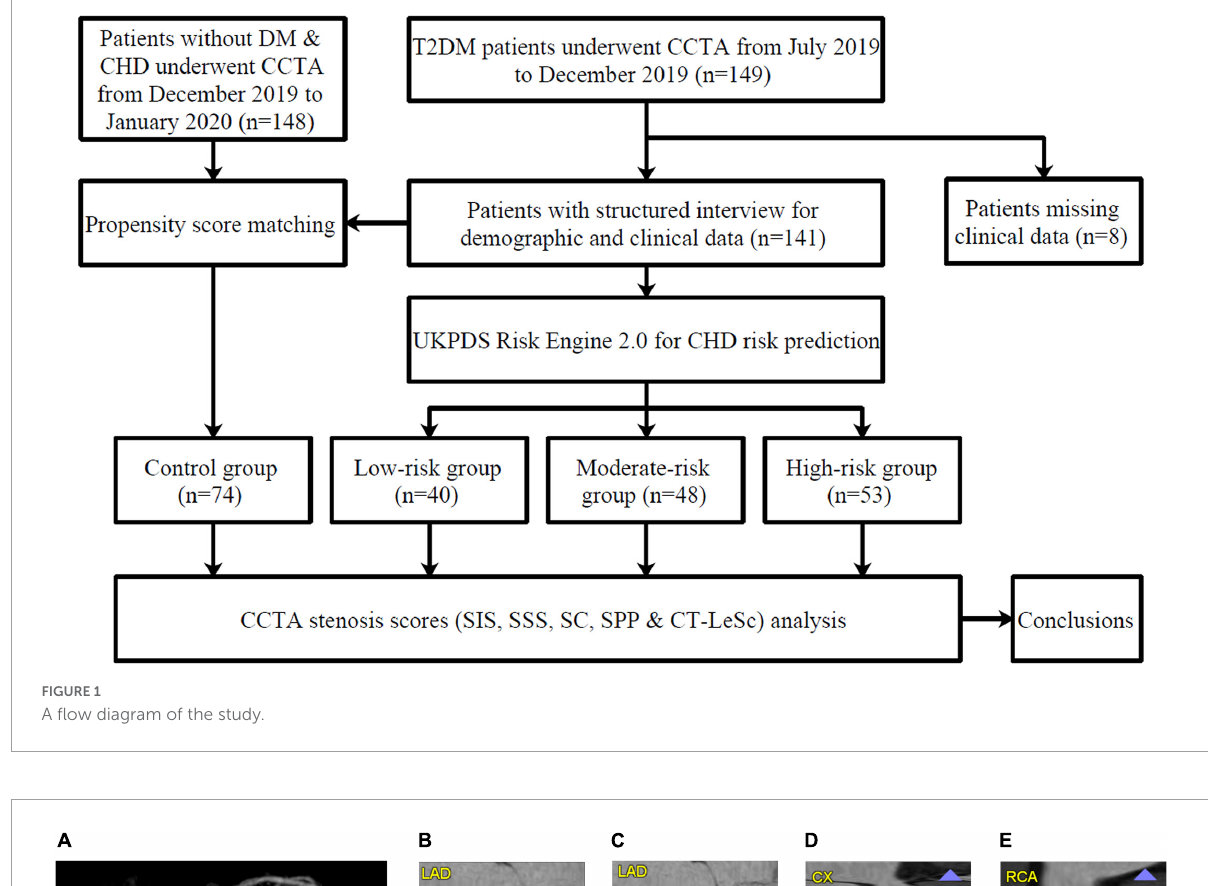
FIGURE1 A flow diagram of the study.